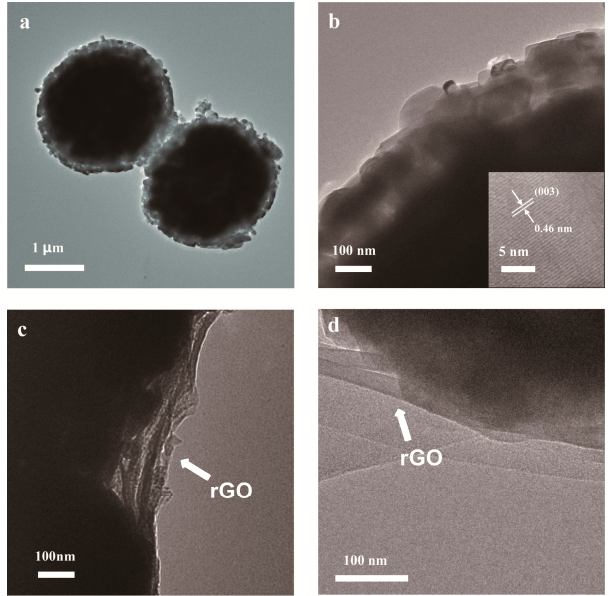
Figure 5. Patterns of ( a , b ) pristine LLO, ( c , d ) LLO@rGO.The weight ratio of rGO to LLO is 0.5%.